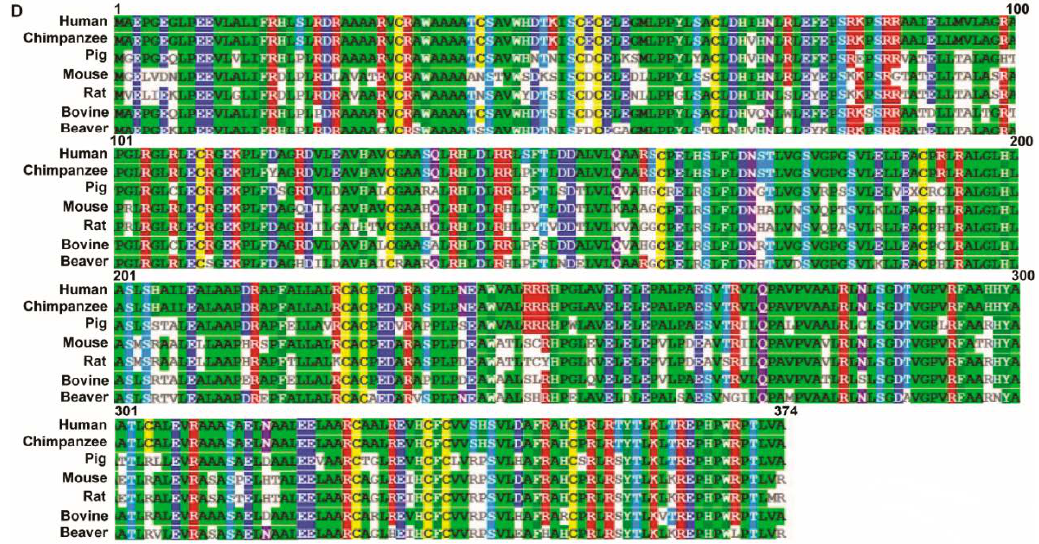
Figure 1. The FBXL8 mRNA level is significantly upregulated in human breast carcinoma tissues. To characterize the expression profiles of F-box family members in human breast cancer (BRCA), a retrospective study was performed by NGS-based RNA-Seq. Breast carcinoma tissues and the corresponding normal counterparts were characterized for their global mRNA profiles. ( A ) Clinicopathological parameters of five representative BRCA patient carcinoma tissue samples were studied. Red arrow highlights the upregulation of FBXL8 . Clinicopathological information provided from medical records includes age, gender (F, Female), pT (Primary Tumour), pN (pathologic lymph node status), pM (Distant Metastasis), etiology and staging of the patients by clinical tumor-node- metastasis. IDC, Invasive ductal carcinoma; ILC, Invasive lobular carcinoma; ER, estrogen receptor; PR, progesterone receptor. ( B ) Quantitative results from each patient. Each data point represents an EdgeR normalized count for FBXL8 (*, FDR < 0.05). ( C ) Box-whisker plot of the FBXL8 mRNA in TCGA breast cancer transcript database. Vertical lines, box and horizontal white line correspond to min-max range, 25–75th percentile range and median, respectively. Data are reported as normalized count as provided in the TCGA level 3 data (**, p < 0.01). ( D ) The sequence alignment of FBXL8